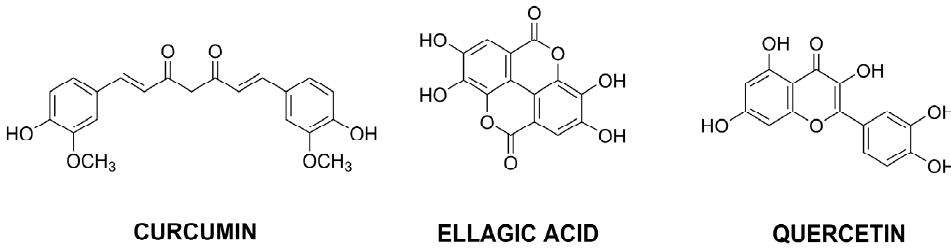
Figure 10. The structures of selected polyphenols with anticancer properties.